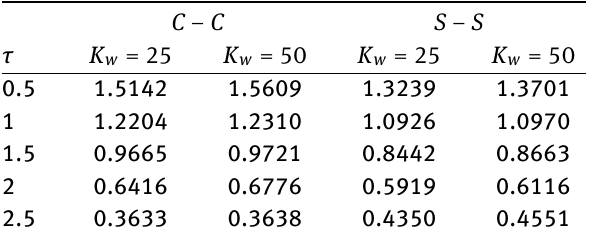
Table 6: Natural frequency (THz) of a S-S CNT for different densities